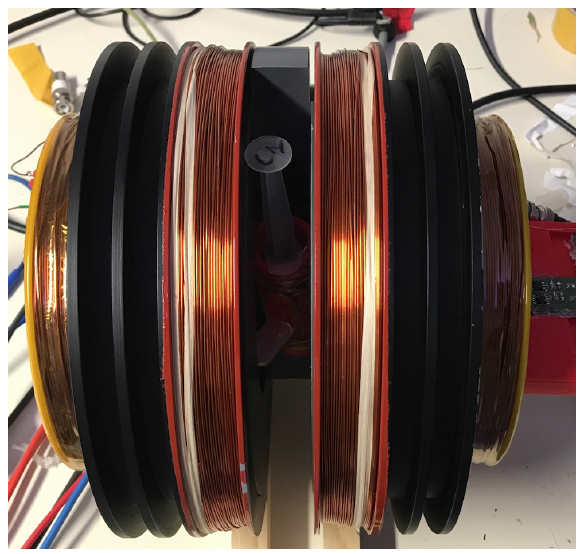
Figure 5. Portable NMR prototype based on the SHS 4 model at 333kHz for agronomic studies ( R = 100mm, N n = 320, window of wire winding: 18mm × 15 layers, r c = 0 . 4mm, and the proto- type total weight =